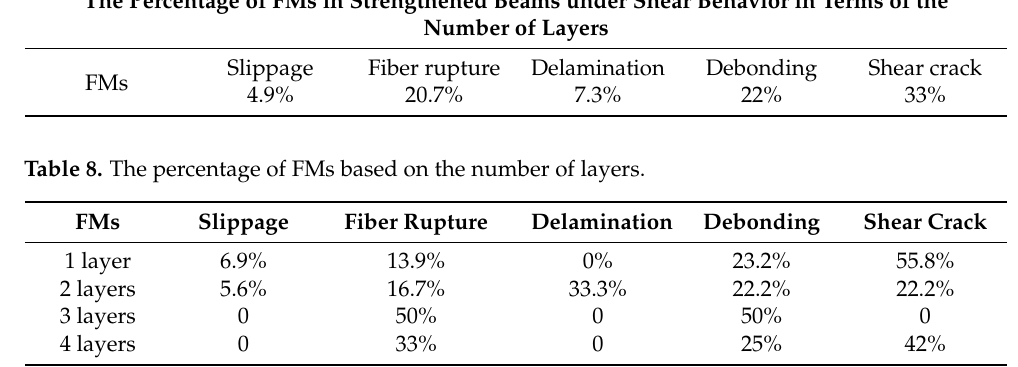
Table 8. The percentage of FMs based on the number of layers.